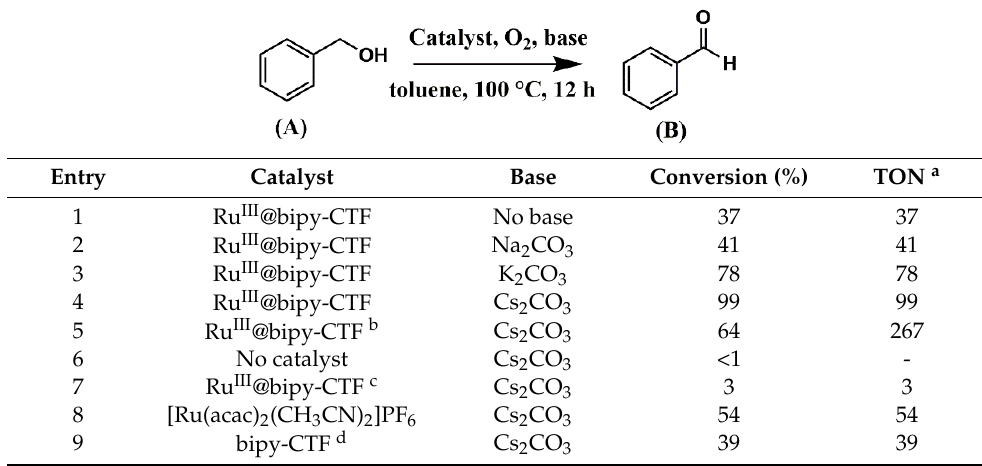
Table 2. Catalytic performance of different catalysts in the oxidation of benzyl alcohol.